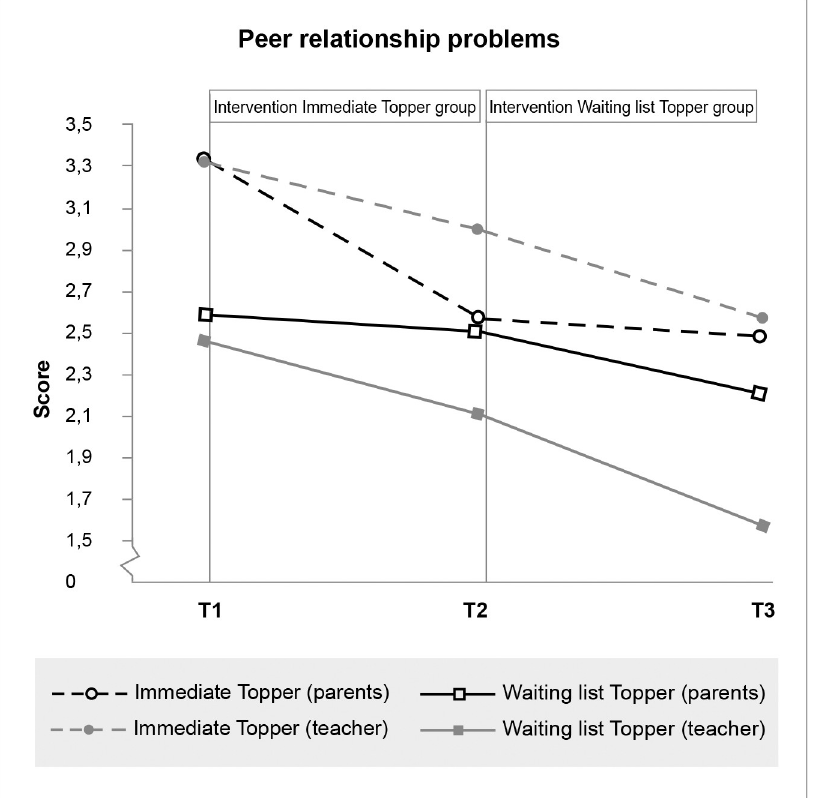
Fig 5. Significant effect of Topper Training on parent-reported (but not teacher-reported) peer relationship problems.